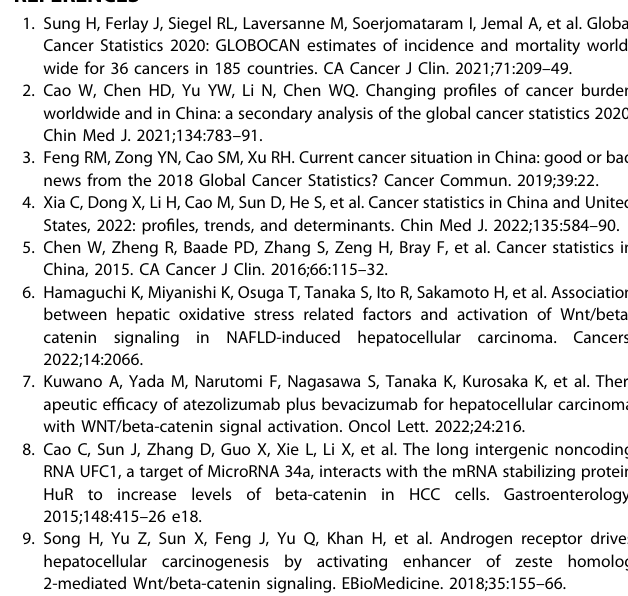
Fig. 6 Knockdown of TRIM26 increased β -catenin protein levels. A The mRNA expression of β -catenin in shTRIM26-transfected SK-hep-1 cell was determined by qRT-PCR. B SK-hep-1 cells were transfected with plasmids overexpressing TRIM26 or control plasmid, and β -catenin mRNA levels were detected by qRT-PCR. C Effect of silencing TRIM26 on the expression levels of Wnt pathway-related proteins was detected by western blotting in SK-hep-1 cells. D The expression of Wnt pathway-related proteins were detected in overexpression TRIM26 SK- hep-1 cells by western blotting. E Immuno fl uorescence staining assays of TRIM26 and β -catenin in SK-hep-1 cells observed by confocal microscopy (scale bar = 60 μ m). F Western blotting was used to determine the effect of knockdown of USP39 on the intracellular distribution of β -catenin protein in SK-hep-1 cells. G SK-hep-1 cells with knockdown (or overexpression) of TRIM26 or control were treated with 0.2 μ g/ml CHX, β -catenin protein level was detected at indicated time points by Western Blotting. H In TRIM26 overexpressing SK-hep-1 cells, MG132 was added to incubate for 24 h, and the protein level of β -catenin was detected by Western blotting. I Detection of ubiquitin status of β -catenin in SK-hep-1 cells with stable knockdown of TRIM26 by immunoprecipitation assay. J HEK-293T cells were transfected with HA- β -catenin and Flag-Ub, total protein was incubated with puri fi ed GST-TRIM26 or GST-Vector in vitro, and the ubiquitination of β -catenin was detected by western blotting. All the data are representative of at least three independent experiments and presented as the means ± SD. (**** p < 0.0001 v.s. control by Student ’ s t